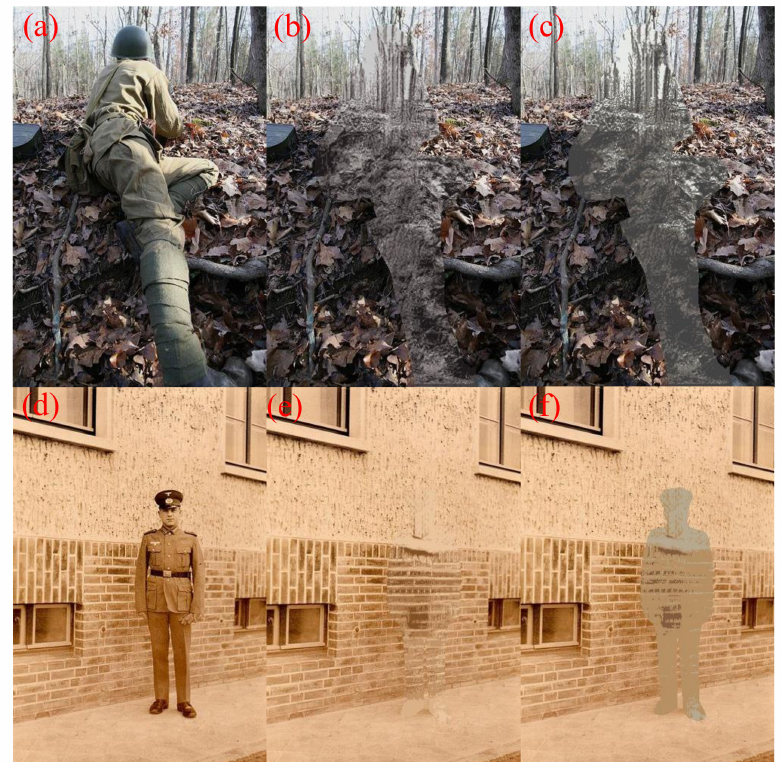
Figure 12. Camouflage textures in natural and artificial environments. ( a ) the original image in natural environment; ( b ) the camouflaged image corresponding to ( a ) whose color wasn’t replaced by standard color; ( c ) the camouflaged image corresponding to ( a ) whose color was replaced by standard color; ( d ) the original image in artificial environment; ( e ) the camouflaged image corresponding to ( d ) whose color wasn’t replaced by standard color; ( f ) the camouflaged image corresponding to ( d ) whose color was replaced by standard